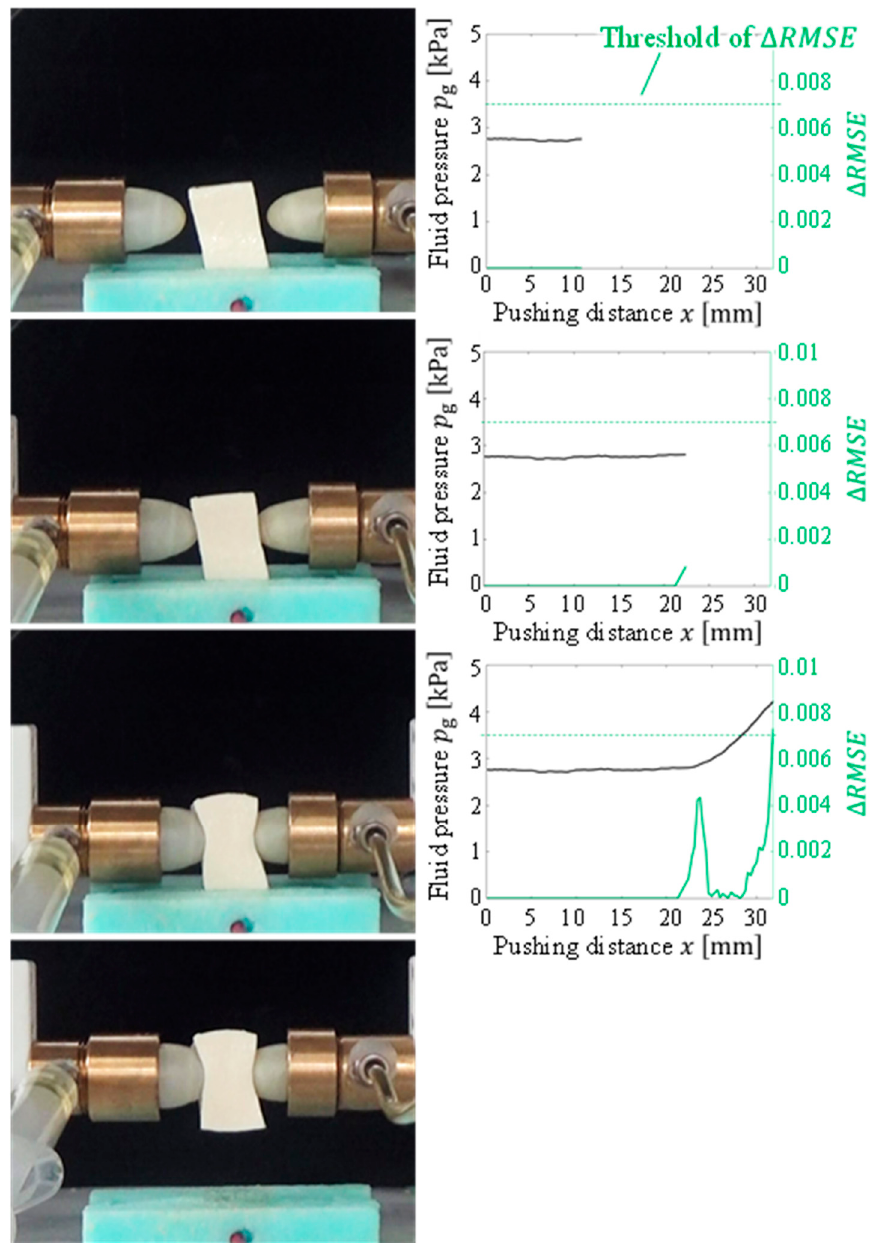
Figure 10. Overview of the grasping test (soft tofu target)